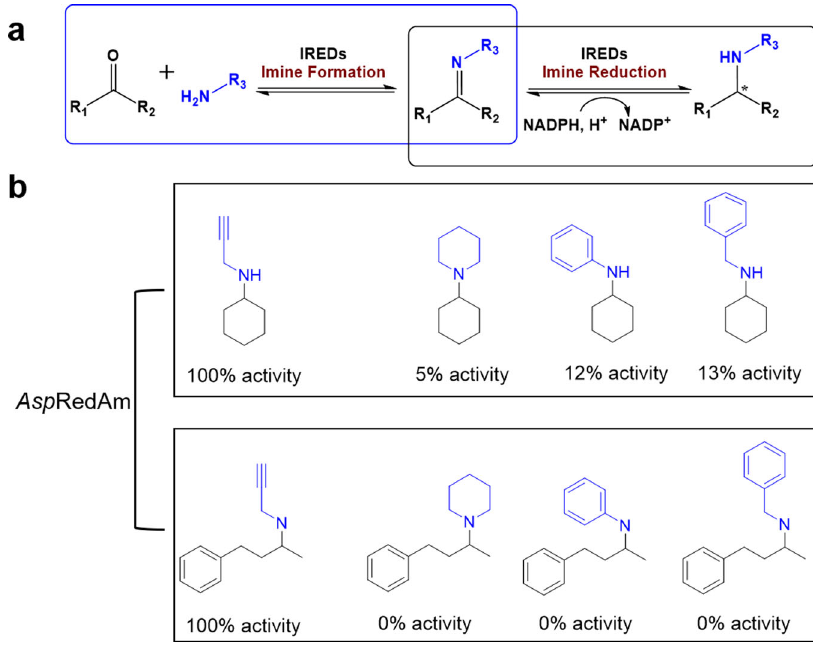
Fig. 1 Synthesis of chiral amines by IREDs. a IREDs are capable of catalyzing imine formation and imine reduction to generate a wide variety of chiral amines. b The reported relative activities of Asp RedAms towards propargylamine and larger amines piperidine, benzylamine, and